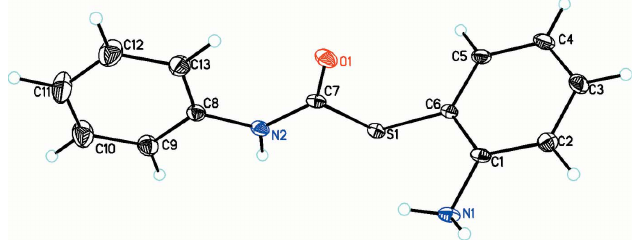
Table 2 Experimental details.